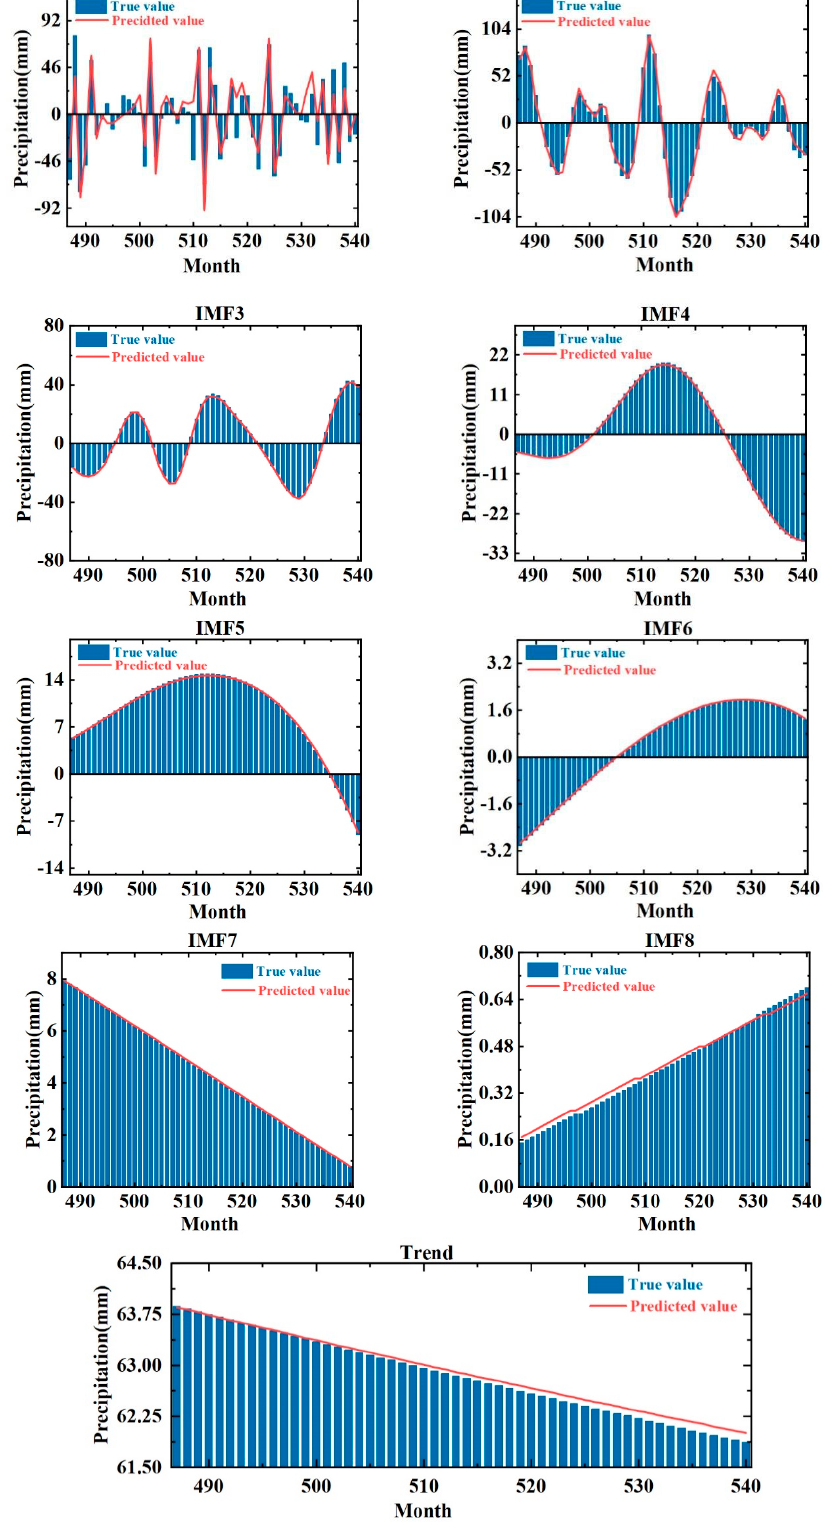
Figure 9. Comparison of the predicted results of IMF1 − 8 and trend terms with the measured values. Among them, the average relative errors of IMF1 and 2 are larger, which is due to their larger frequencies. The average relative error from IMF1 to the trend term gradually decreases, and combined with Figure 9, it can be seen that the predicted values of each component basically match with the true values. Therefore, after CEEMD preprocessing,